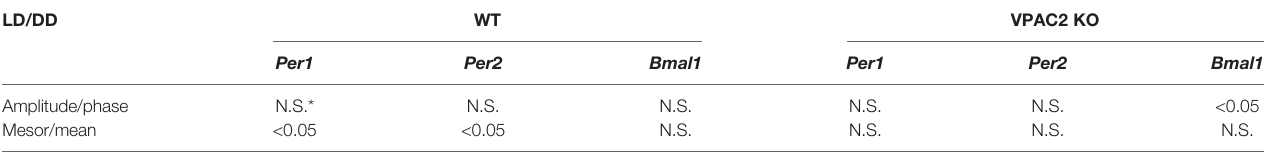
TABLE 4 | Signi fi cance of differences in rhythmometric parameters from Tables 1 and 3 between light-darkness and constant darkness in wildtype (WT) and VPAC2 receptor knockout mice (VPAC2 KO), respectively. LD/DD